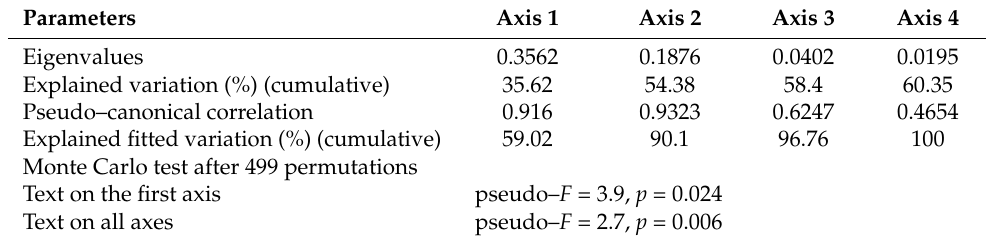
Figure 5. Redundancy analysis between main groups of the soil fauna and the selected properties of soil. Red arrows represent soil properties labeled as: soil bulk density (BD), soil pH value (pH), soil organic matter (SOM), total nitrogen (TN), and total phosphorus (TP). Black arrows represent groups of soil fauna labeled as: Acarina ( Aca. ), Araneae ( Ara. ), Collembola ( Col. ), Dermaptera ( Der. ), Diplopoda ( Dip. ), Diptera adult ( Dip. (A) ), Diptera larvae ( Dip. (L) ), Enchytraeidae ( Enc. ), Isoptera ( Iso. ), Psocoptera ( Pso. ), and Thysanoptera ( Thy. ). Table 5. Eigenvalues and taxa-environment correlation coefficients for the RDA ordination axes.